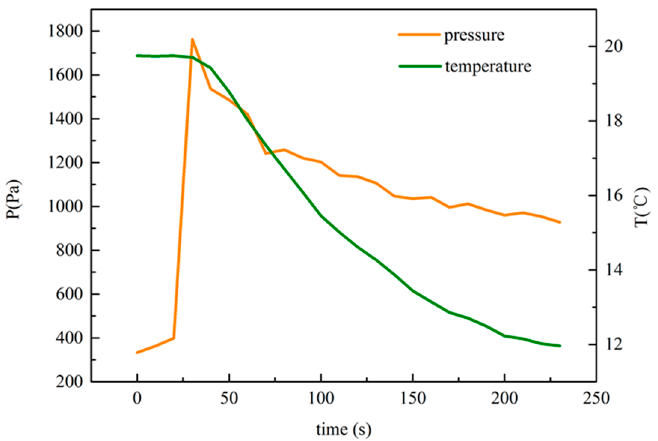
Figure 7. Variation of temperature and pressure in the process of pumping out air of the evaporator/condenser.